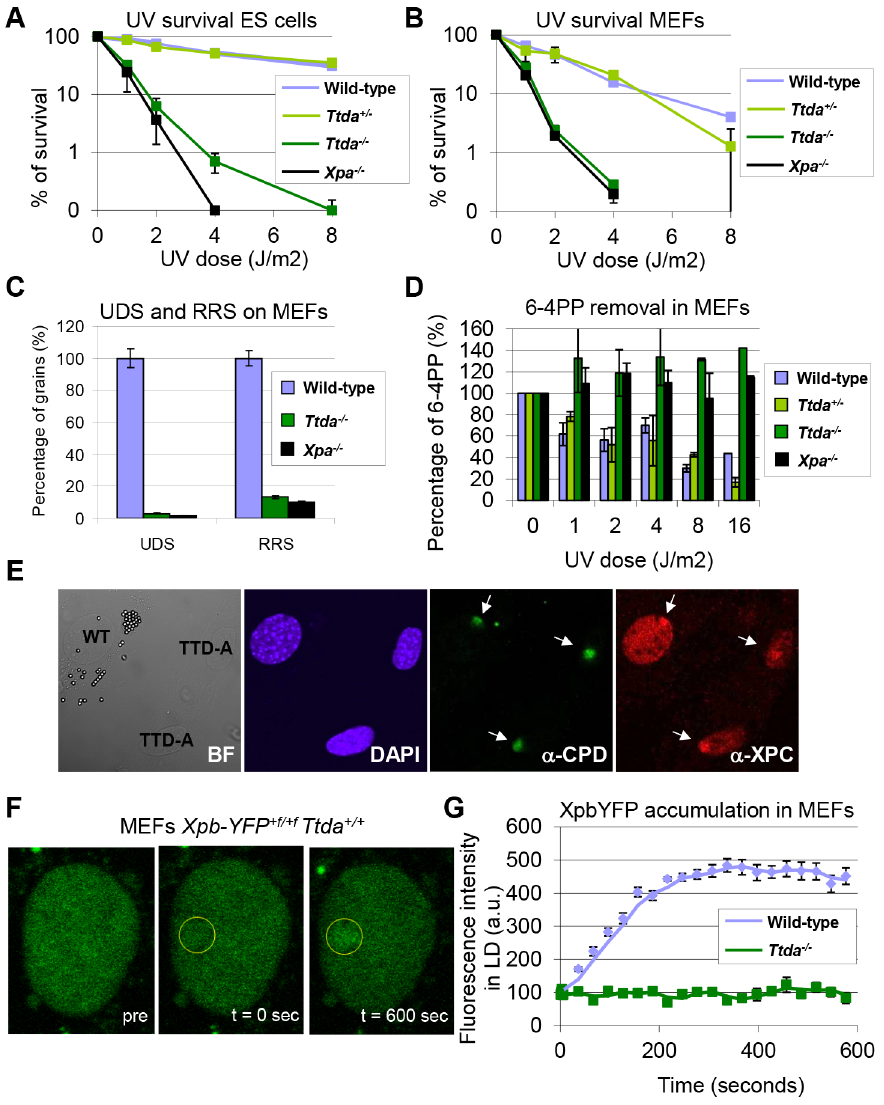
Figure 2. Repair capacity of Ttda 2 / 2 cells. (A) Colony forming ability after different doses of UV of wild-type, Ttda + / 2 . Ttda 2 / 2 and Xpa 2 / 2 ES cells. The percentage of surviving cells was plotted against the applied UV-dose, measured by counting surviving colonies of two independent experiments and at least 2 different clones per genotype. The error bars indicate the SEM. (B) Survival assay after different doses of UV of wild-type, Ttda + / 2 , Ttda 2 / 2 and Xpa 2 / 2 MEFs. The percentage of surviving cells was plotted against the applied UV-dose, measured by [ 3 H]-thymidine incorporation of two independent experiments and at least 2 different clones per genotype. The error bars indicate the SEM. (C) DNA repair synthesis (UDS) and recovery of RNA synthesis (RRS) was measured by autoradiography. For the UDS assay, directly after exposure to 16 J/m 2 UV-C MEFs were pulse labeled with medium containing [methyl- 3 H] Thymidine, washed with PBS and fixed. For the RRS assay, 16 hours after exposure to 16 J/m 2 MEFs were pulse labeled with medium containing [ 3 H] Uridine, washed with PBS and fixed. UDS and RRS are expressed as the percentage of autoradiographic grains above wild-type, which was set at 100%. (D) 6-4PP removal assayed by ELISA using a 6-4PP specific antibody of wild-type, Ttda + / 2 . Ttda 2 / 2 and Xpa 2 / 2 MEFs irradiated with 5 J/m 2 (UV-light). DNA was isolated at different time-points after UV irradiation (0, 1, 2, 4, 8, and 16 hrs post UV). The amount of 6-4PP measured directly after UV was set at 100%. (E) Immuno-fluorescent analysis of XPC recruitment to local UV- damage in wild-type (labeled with 2 m m latex beads) and Ttda 2 / 2 MEFs. Cells were seeded in a 1:1 ratio on cover slips and the next day irradiated with 60 J/m 2 through a filter containing 5 m m pores. Cells were fixed 1 hour after UV and immuno-fluorescent staining was performed using antibodies against CPDs (damage marker, green) and XPC (green). (F) Representative series of confocal images of XpbYFP + f/ + f MEFs before (left; pre), directly after (middle; t=0 sec) and 600 seconds after (right; t=600 sec) local UV-damage infliction, the yellow circle marks the area irradiated with the UV-laser. (G) Accumulation kinetics of XpbYFP to local UV-C (laser-induced) DNA damage in a wild-type and Ttda 2 / 2 background. Graphs represents the mean YFP-derived fluorescence intensity at the damaged spot at the indicated time points from approximately 12 cells. doi:10.1371/journal.pgen.1003431.g002 explained by a possible combinational functional interference of S3A). To further investigate a possible partial function of the both the 16 amino acid N-terminal truncation and the C-terminal translational start-site mutant, we over expressed non-tagged GFP-tag, despite the notion that over expression of a full length mutant TTDA cDNA — mimicking the translation start mutation TTDA-GFP rescues the UV-sensitivity of Ttda 2 / 2 MEFs (Figure found in TTD13 PV and TTD14 PV patients — and the other